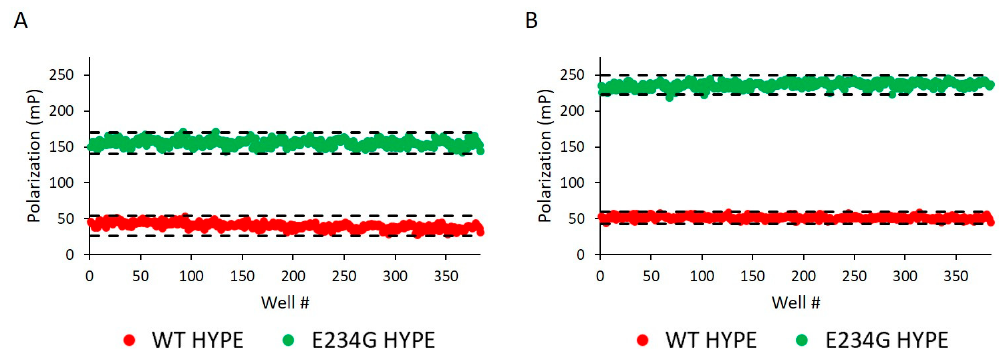
Figure 4. Assay reproducibility assessment. ( A ) 200 nM ∆ 102 WT and E234G HYPE autoAMPylation reactions were measured for FP on separate 384-well microplates. Z’ = 0.749 and S / B = 3.875. Each dot represents a single AMPylation reaction in a separate well. Black dash lines represent three standard deviations plus or minus the control means. ( B ) As in ( A ) but the mean of two independent 400 nM ∆ 102 HYPE plates. Mean Z’ = 0.884 and mean S / B = 4.598.